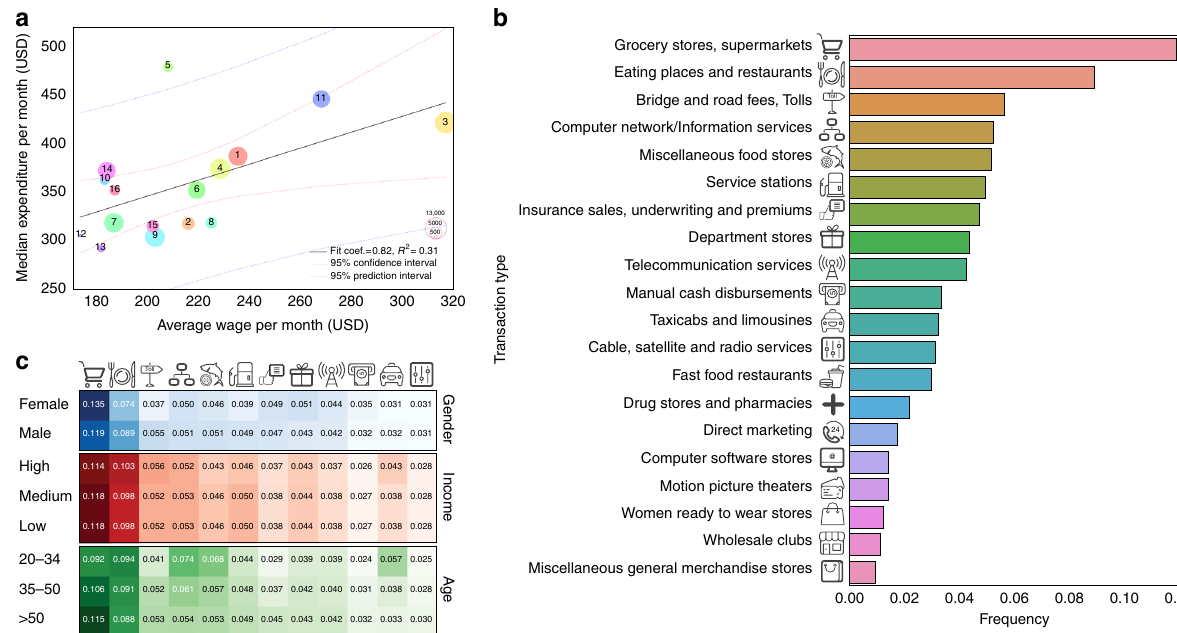
Fig. 1 Transaction frequency by type and their demographics. a User median expenditure per month in CCR transactions vs. the average monthly wage in their district of residence. The color and the number represent different districts of Mexico City (see Supplementary Figure 1), and the size of the circles is proportional to the number of users in the district. b Transactions by type as de fi ned by MCC 29 . c Comparison of frequencies by transaction types (same as in b ) separating users in groups according to their gender, income, and age. The share of transaction frequency is distributed similarly among different groups. The icons used in this fi gure are work of Azaze11o/Shutterstock.com